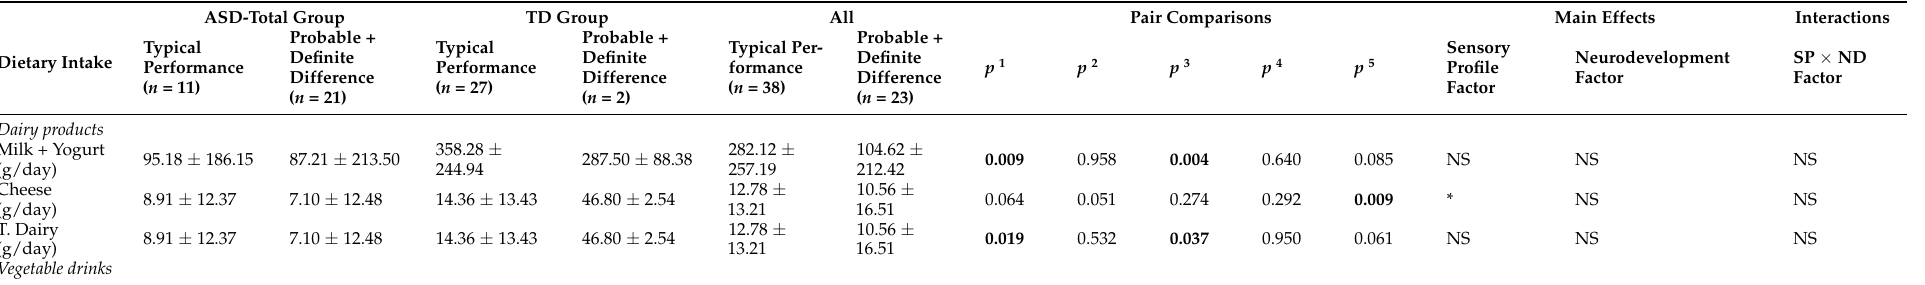
Table 4. Comparison of dietary intake between sensorial profile groups (typical performance and probable + definite difference) and neurodevelopment groups (autism spectrum disorder vs. typical development group) by two-way